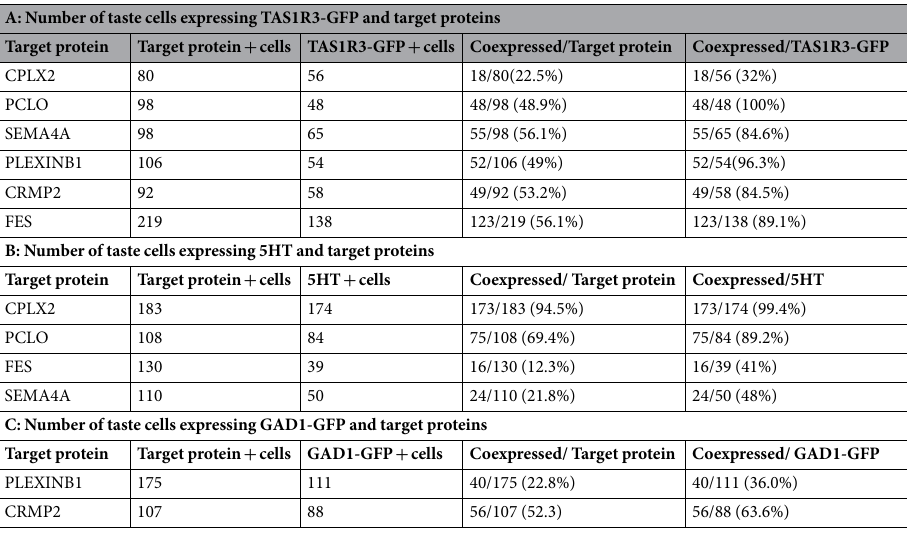
Table 2. Coexpression of the synaptic vesicle components (CPLX2 and PCLO) and the semaphorin signalling components (SEMA4A, PLEXINB1, CRMP2 and FES) with (A) TAS1R3-GFP, (B) 5HT and (C) GAD1-GFP in circumvallate papillae taste cells of